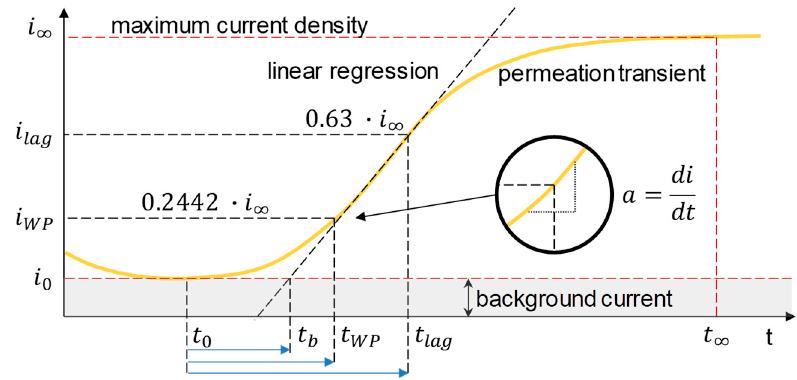
Figure 3. Schematic representation of an idealized permeation curve with the significant points.